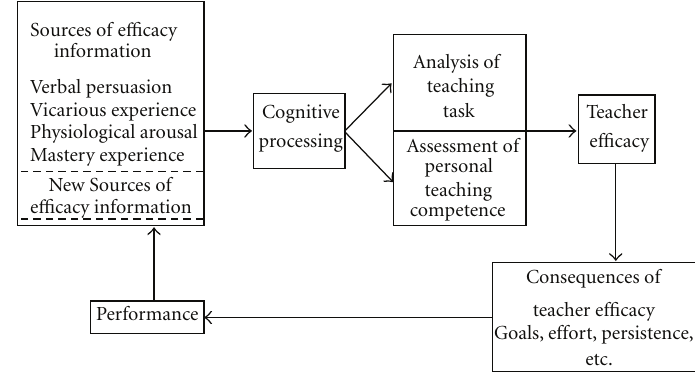
Figure 1: The cyclical nature of teacher e ffi cacy